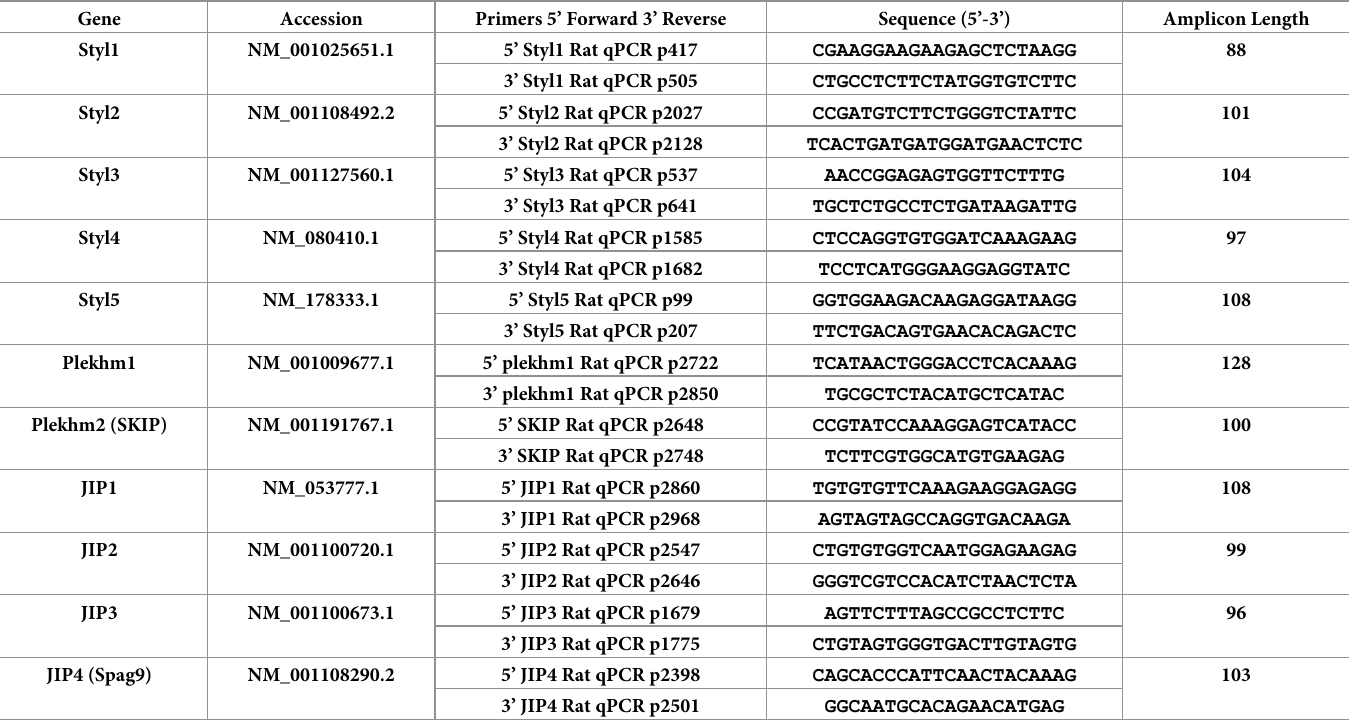
Table 1. qPCR primers for Kinesin-1 cargo adaptor